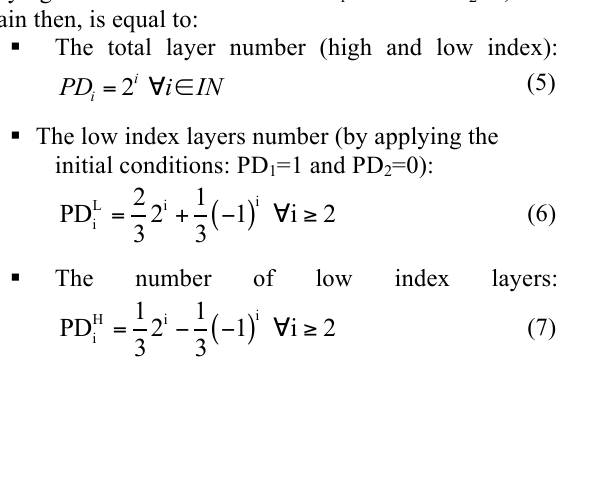
For such a structure the number of the layers, high index (H) and low index (L), at the i th iteration is given